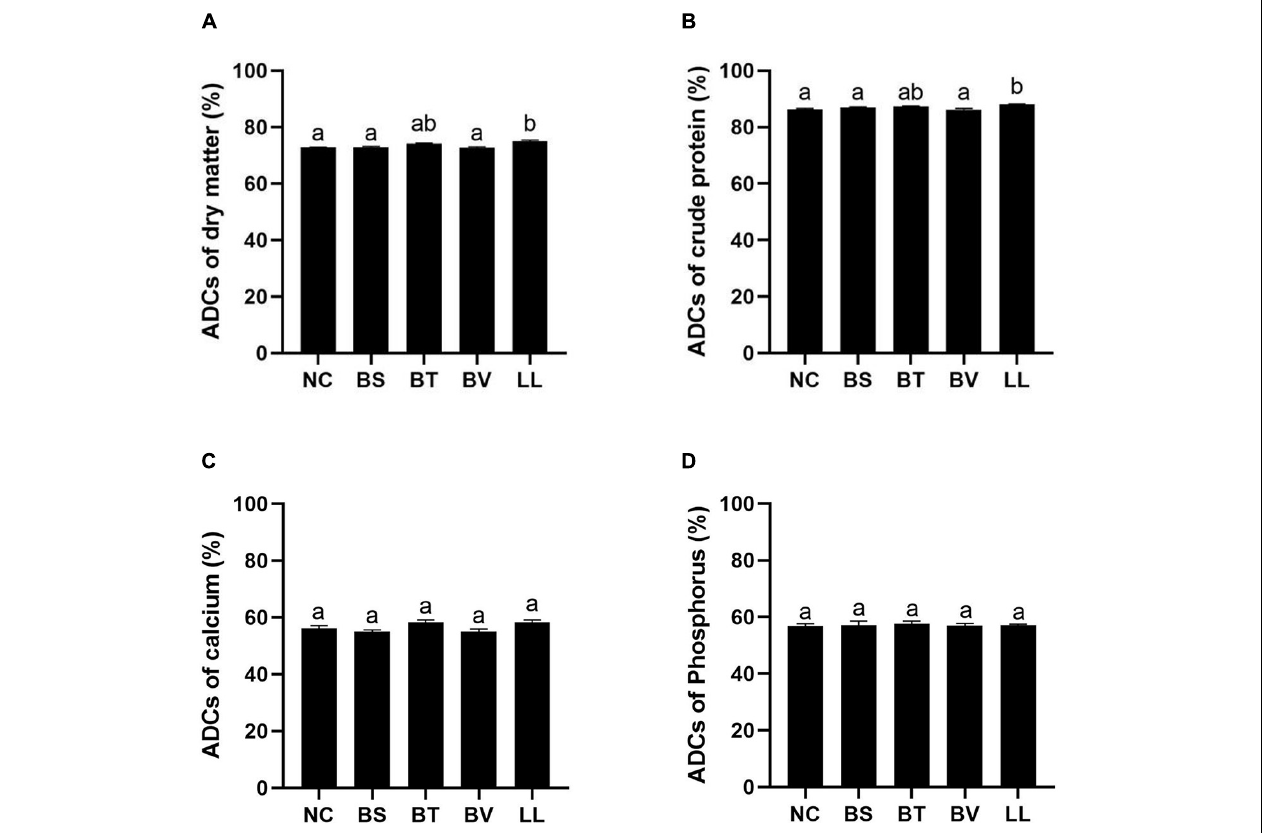
FIGURE 1 | Apparent digestibility coefficients (ADCs) of nutrients: (A) dry matter, (B) protein, (C) calcium, and (D) phosphorus. Bars with different letters were significantly different ( p < 0.05). NC, control diet; BS, control diet containing 1 × 10 7 CFU/g of Bacillus siamensis ; BT, control diet containing 1 × 10 7 CFU/g of Bacillus tequilensis ; BV, control diet containing 1 × 10 7 CFU/g of Bacillus velezensis ; and LL, control diet containing 1 × 10 7 CFU/g of Lactococcus lactis